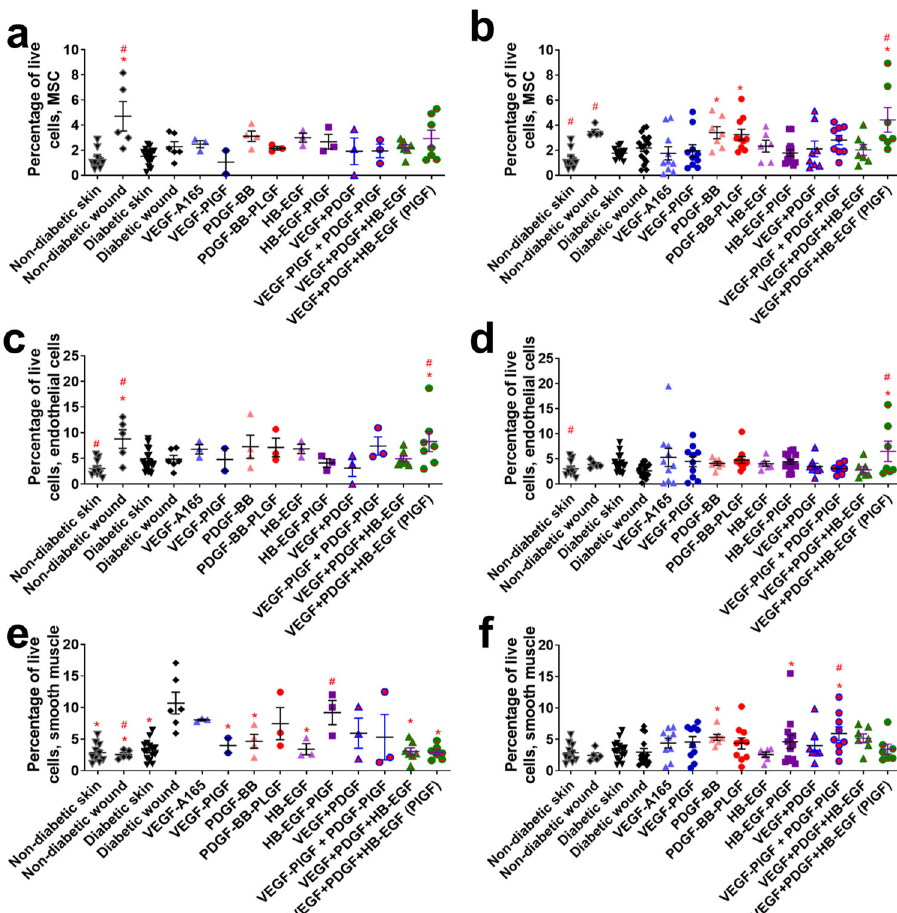
Fig. 5 Non-hematopoietic cell count in wounds after 3 – 7 days of healing. Mesenchymal stem cells (CD45 − , CD44 + , CD29 + , CD90 + , SCA-1 + ) after ( a ) 3 days or ( b ) 7 days. Endothelial cells (CD45 − , CD31 + ) after ( c ) 3 days or ( d ) 7 days. Smooth muscle cells CD45 − , SMA + ) after ( e ) 3 days or ( f ) 7 days. Comparison includes unwounded skin from both the NOD and NOR mice. n ranges from 3 to 20. * Denotes comparison to the diabetic wound. # Denotes a comparison between untreated NOD wound and untreated NOR wound, and the WT GF(s) are compared to their counterpart -PLGF-2 123 – 144 variant(s), e.g., VEGF vs VEGF- PlGF-2 123 – 144 . * p < 0.05, p < 0.01, p < 0.001, Kruskal-Wallis + Mann-Whitney post hoc test. # p < 0.05, p < 0.01, p < 0.001, Mann-Whitney. Error bars are